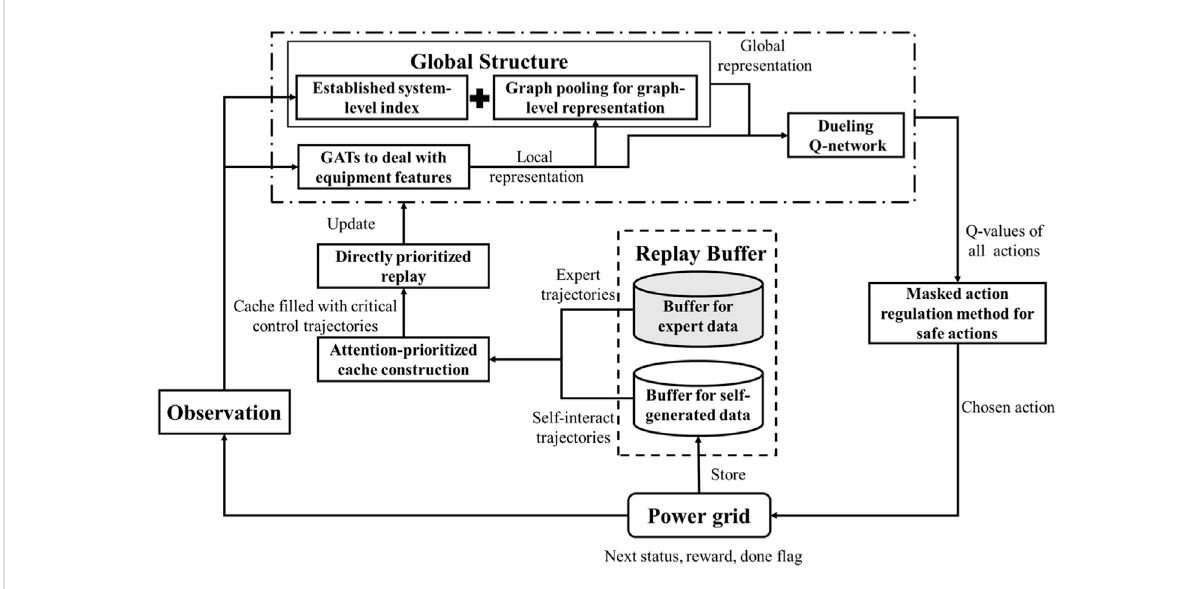
FIGURE 1 The overall architecture of the proposed PKE-RL